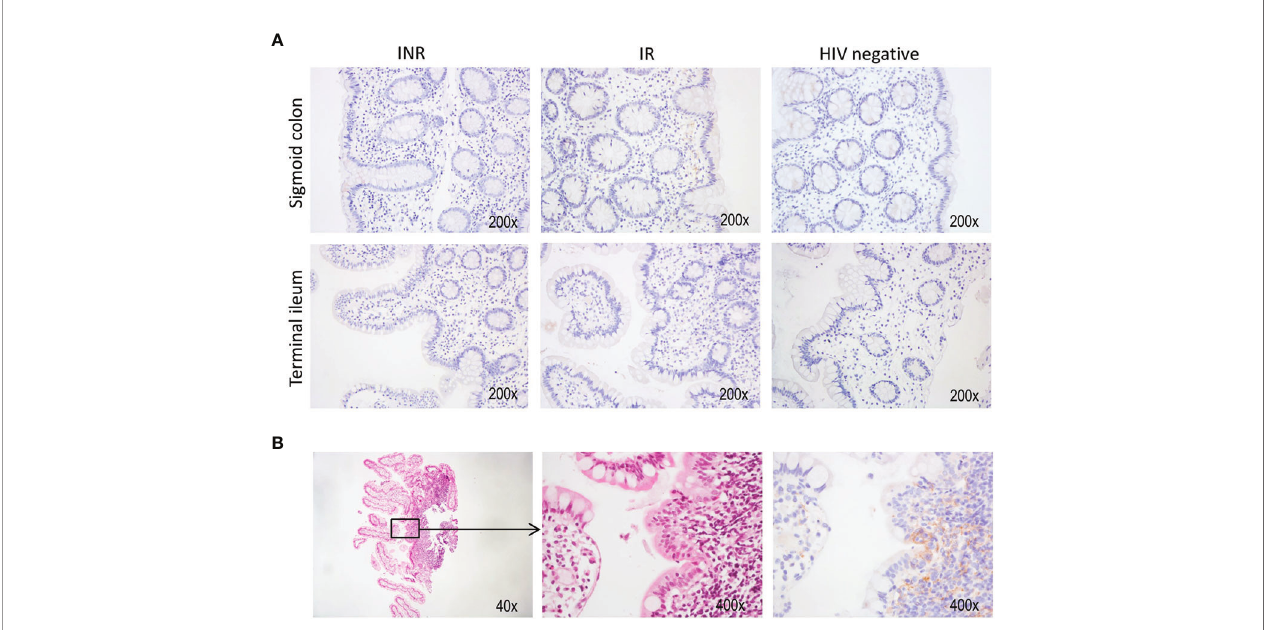
FIGURE 5 | HIV infected patients lack PD-L1 expression in mucosa. Immunohistochemistry was performed on a selection of nine patients to assess the expression of PD-L1 in both sigmoid colon and terminal ileum. (A) Representative stainings from both anatomical sites in each patient group. (B) Hematoxylin-eosin (left and middle panel) and anti-PD-L1 (right panel) staining of a biopsy from the terminal ileum. This sample also contained tissue from a lymphoid